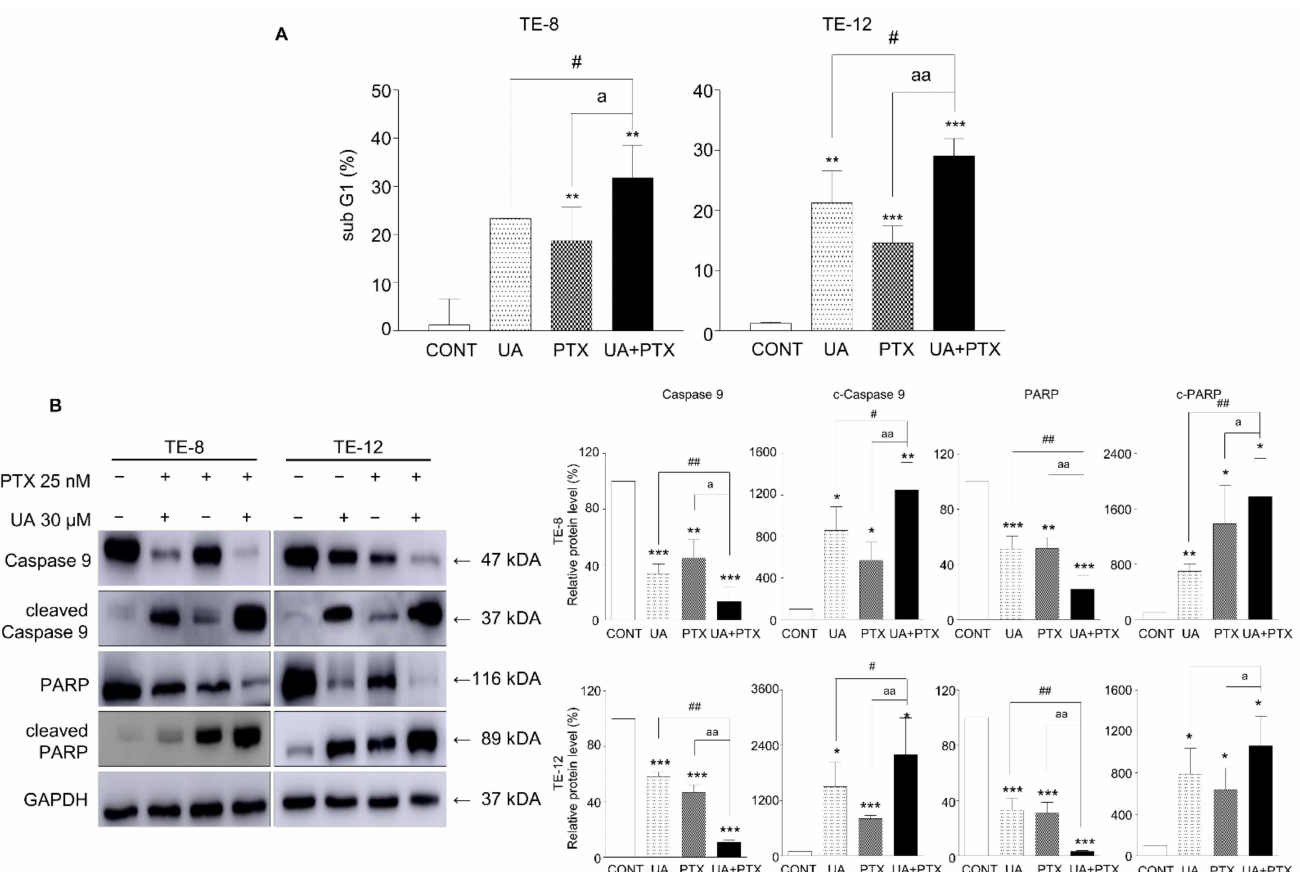
Figure 2. UA and PTX induced apoptosis in ESCC cells. ( A ). The sub-G1 phase population was detected using a FACS analysis. ( B ). The expression of cleaved-PARP, cleaved caspase 9, PARP, and caspase 9 was measured by western blotting after treatment with UA 30 µ M, PTX 25 nM, or both. GAPDH is the internal control. Quantification of bands was calculated using ImageJ. Data are expressed as the mean ± SE. *, compared with the control group; # , UA compared with the UA plus PTX combination group; a , PTX group compared with the UA plus PTX combination group. # , a , * p < 0.05; ## , aa , ** p < 0.01 and *** p < 0.001. CONT, control; UA, ursolic acid 30 µ M; PTX, paclitaxel 25 nM; UA+PTX, combination treatment of ursolic acid 30 µ M and paclitaxel 25